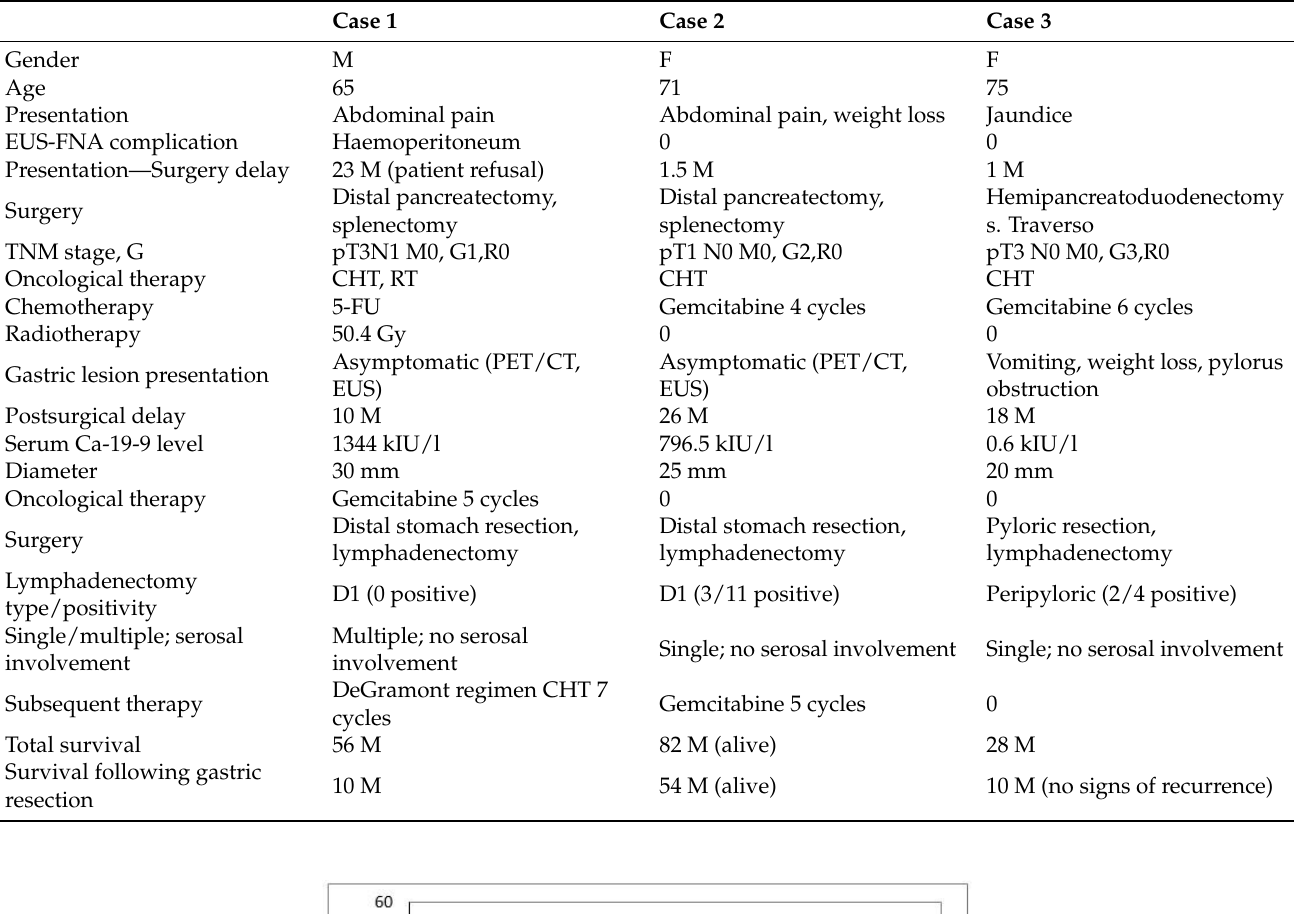
Table 2. Clinical characteristics of patients with proven gastric seeding of PDAC.